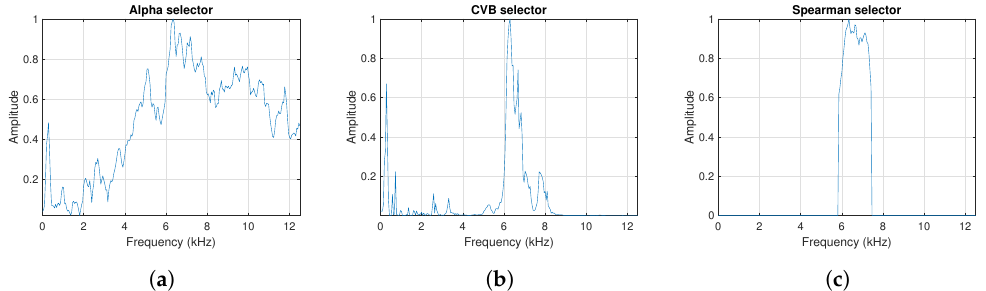
Figure 41. The considered IFB selectors for the real signal r . ( a ) Alpha selector. ( b ) CVB selector. ( c ) Spearman